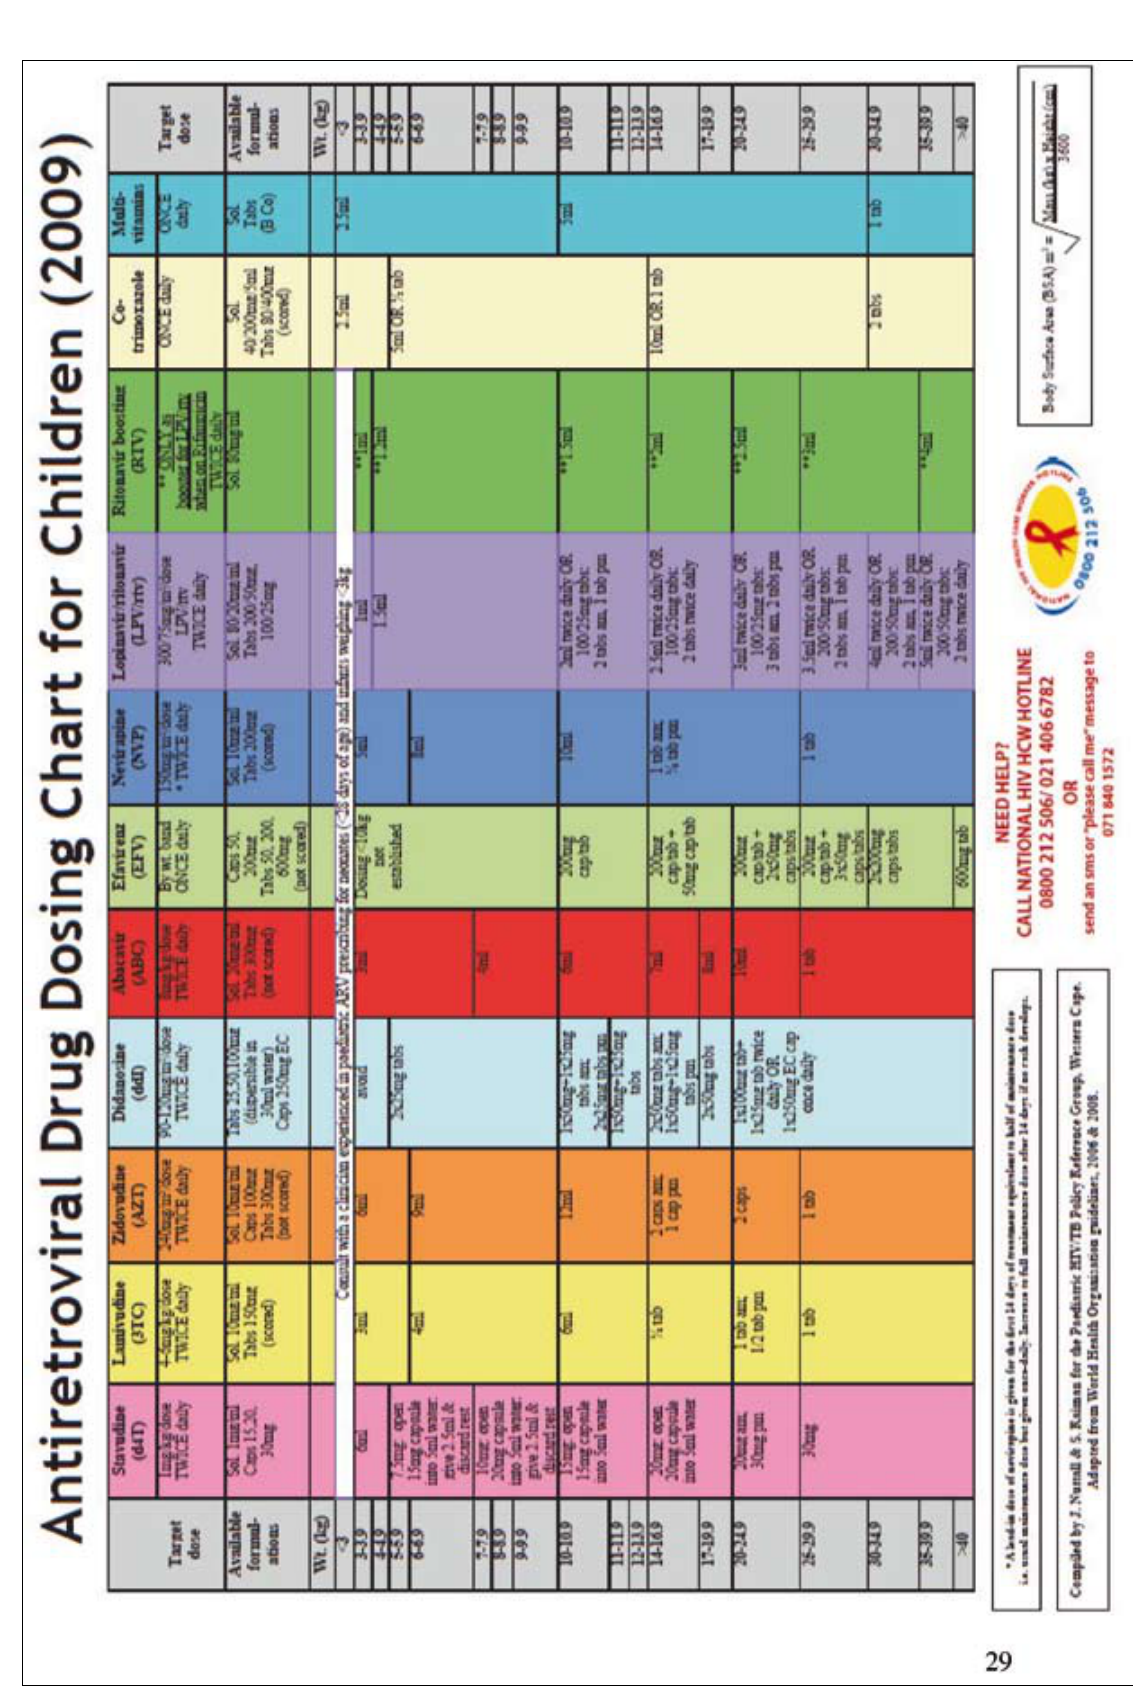
Fig. 1. Weight-based dosing